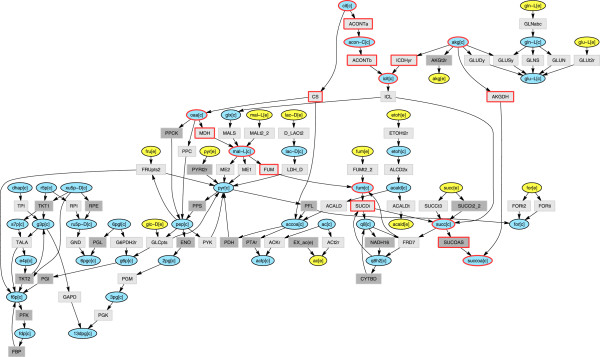
Network representation of E. coli core metabolism. This reconstruction refers to the work of Orth et al.[35] and maintains the same notation. Metabolites are in ellipses (yellow color: external nutrients; blue color: cytoplasmatic compounds) and reactions in boxes (dark gray for irreversible and light gray for reversible processes). Nodes highlighted with red border belong to Krebs cycle. For a better readability, common species like water, Oxygen, H+, Ammonium, CO2, phosphate, NAD (in all forms), Coenzyme-A, AMP, ADP and ATP, as well as all transport and exchange processes, have been excluded from the representation.